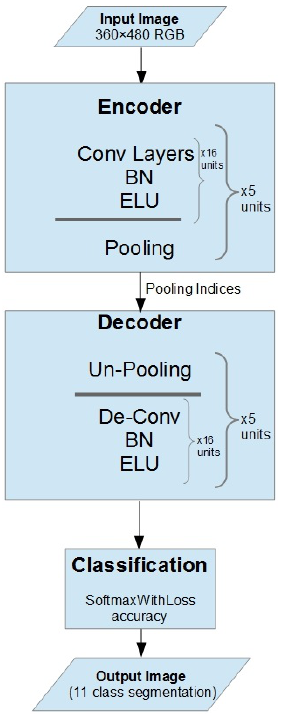
Figure 1. Flowchart of the algorithms. BN, Batch